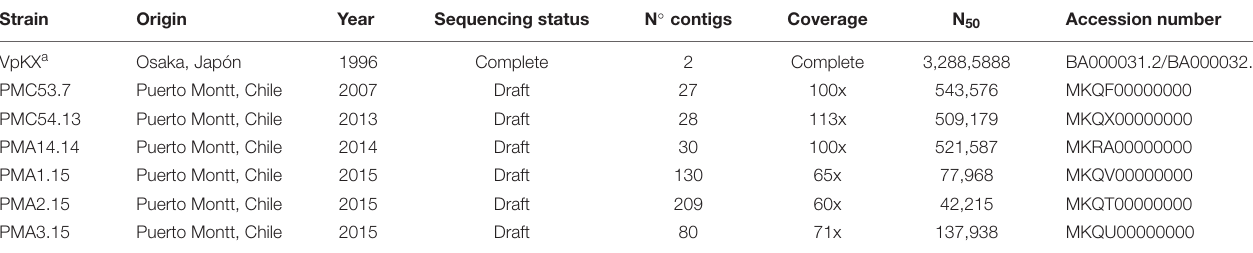
TABLE 1 | Origin of V. parahaemolyticus strains whose DNA sequences were included in this study.